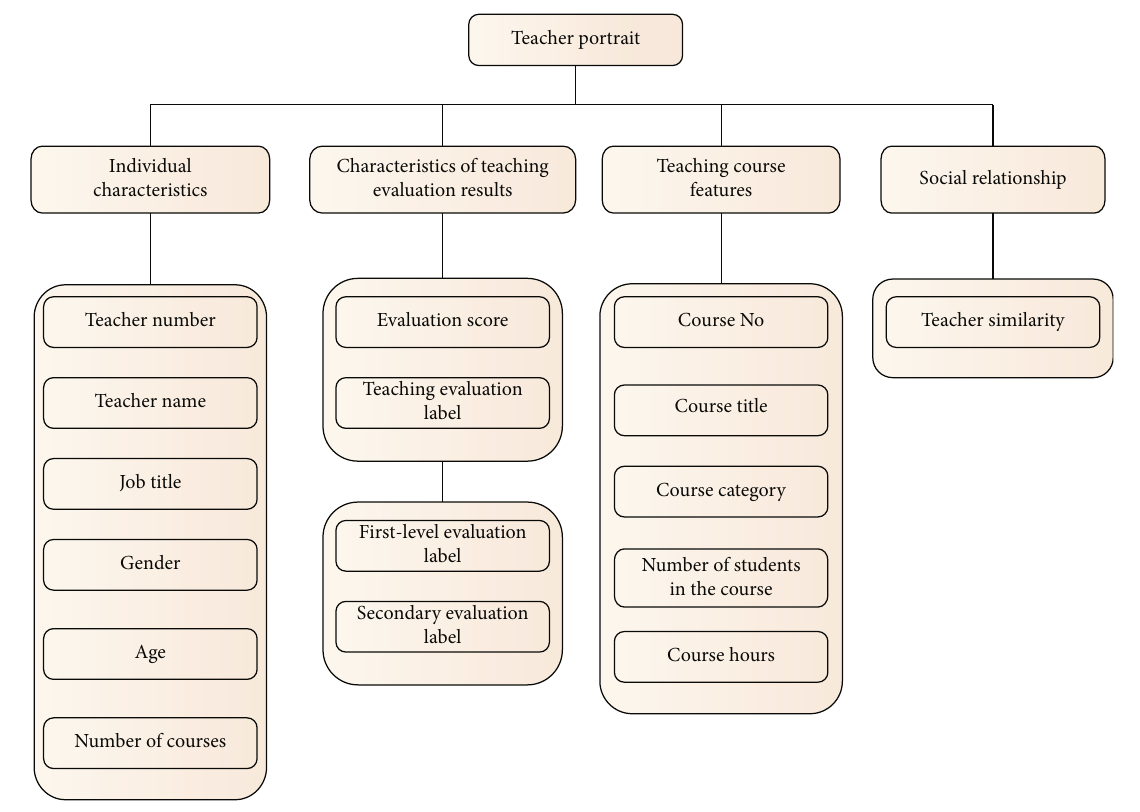
Figure 3: Multilevel teacher portrait